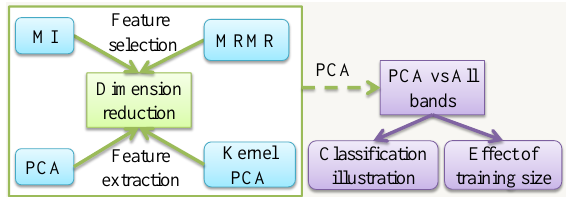
Figure 7. Flowchart of experimental verification.